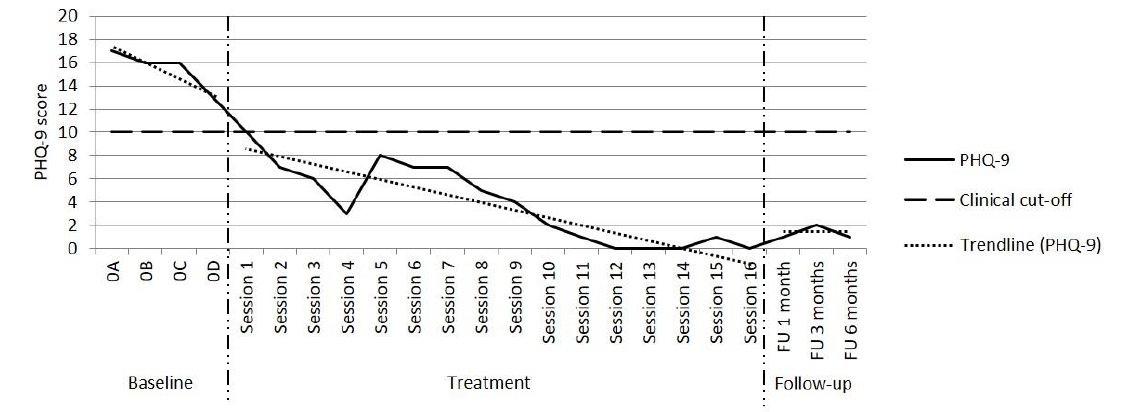
Figure 1: Margherita’s weekly depressive (PHQ-9)